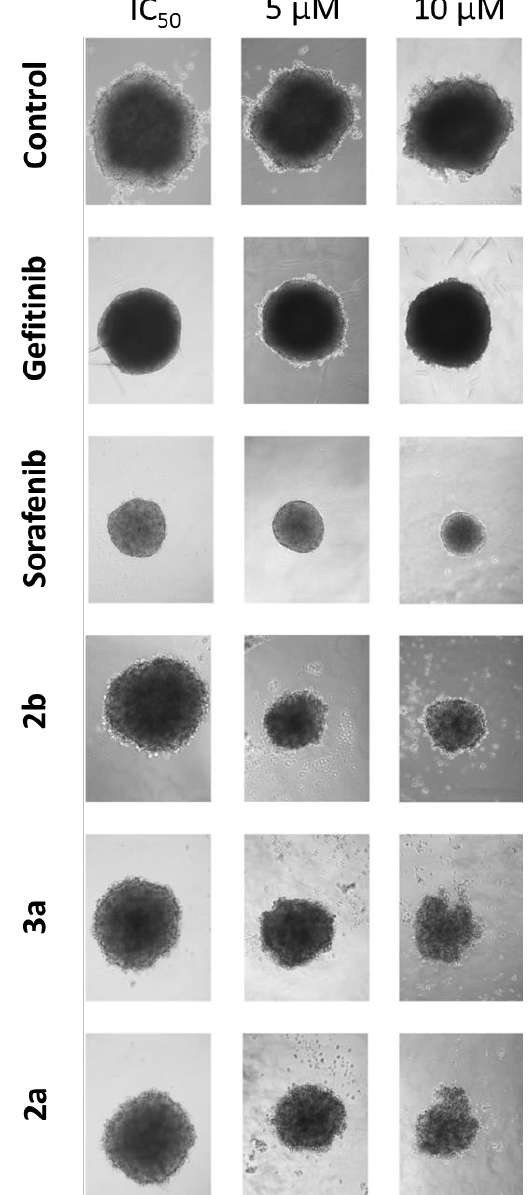
Figure 9. Suppression of tumor spheroids by 2a , 2b and 3a in HCT-116 p53-knockout cells. Sorafenib and gefitinib were used as positive controls. Representative images from four experiments, 100× magnification.